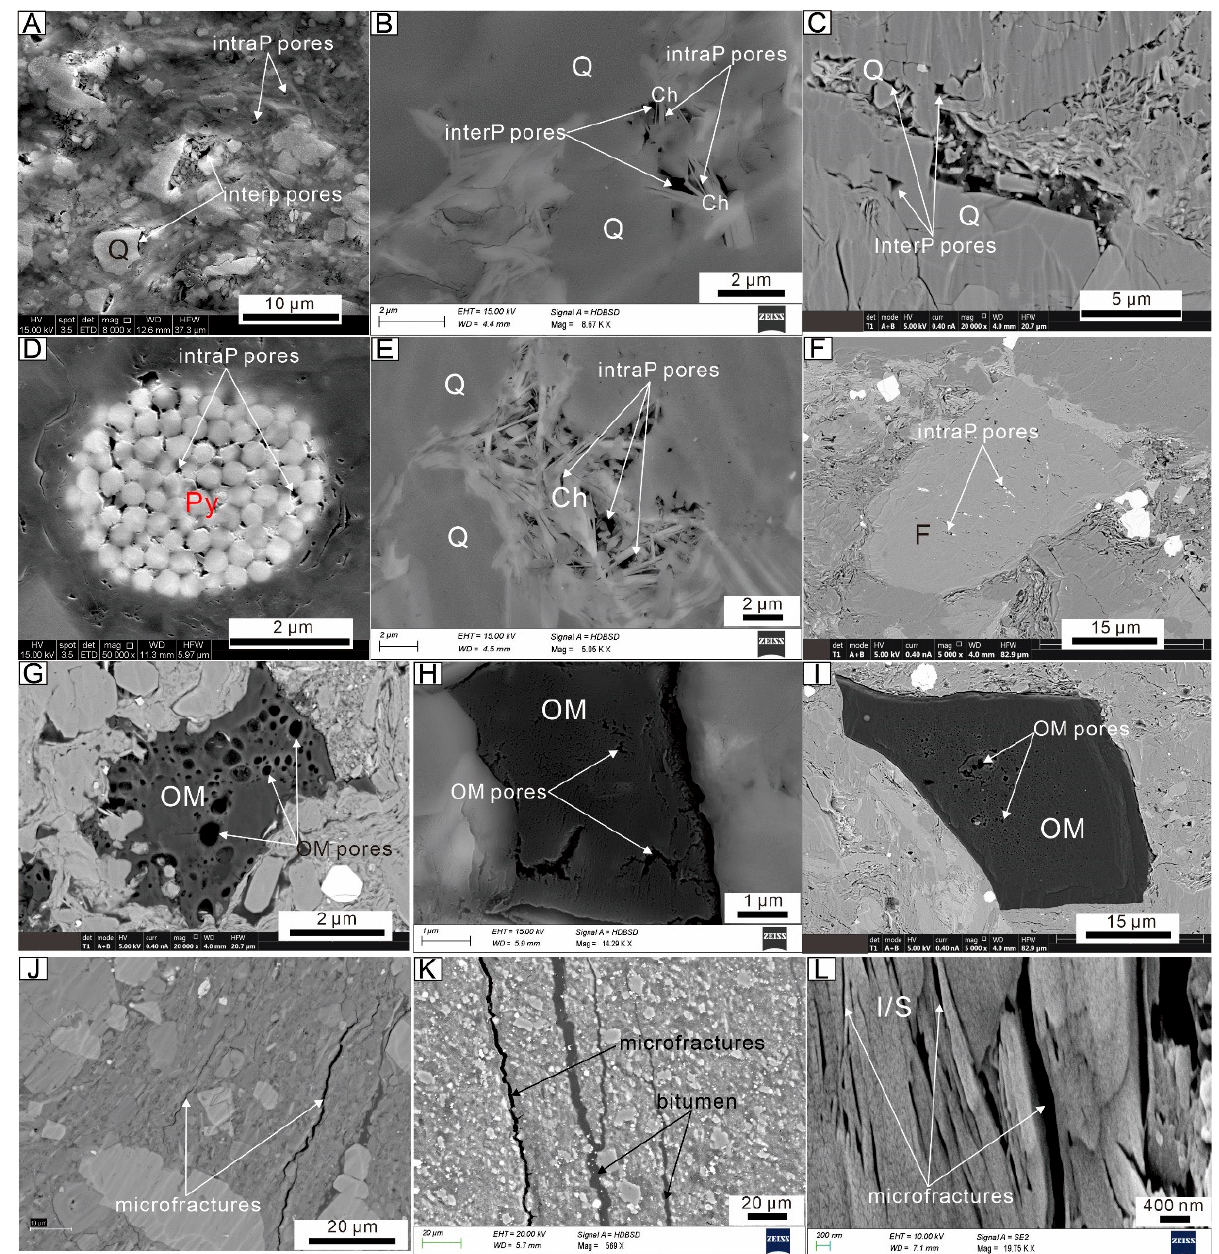
Figure 11. Pore types of the FGSRs in the Qingshankou Formation. (Abbreviations: Ch = chlorite; Q = quartz; Py = pyrite; F = feldspar; OM = organic matter; I/S = mixed ‐ layer illite/smectite). ( A ) InterP pores between rigid grain and clay mineral, well X8HC, 2446.2 m; ( B ) interP pores between grain and chlorite, well X8HC, 2438.6 m; ( C ) interP pores between rigid grains, well X8HC, 2523.11 m; ( D ) intraP pores in pyrite, well X8HC, 2328.0 m; ( E ) intraP pores in chlorite, well X8HC, 2438.6 m; ( F ) intraP pores in dissolved feldspar, well X8HC, 2435.0 m; ( G ) OM pores, well X8HC; ( H ) OM pores, well X8HC, 2491.07 m; ( I ) OM pores, well X8HC, 2317.1 m; ( J ) microfractures, well X8HC, 2520.0 m; ( K ) microfractures, well X3HC, 2431.17 m; ( L ) microfractures, well X8HC, 2561.66 m.